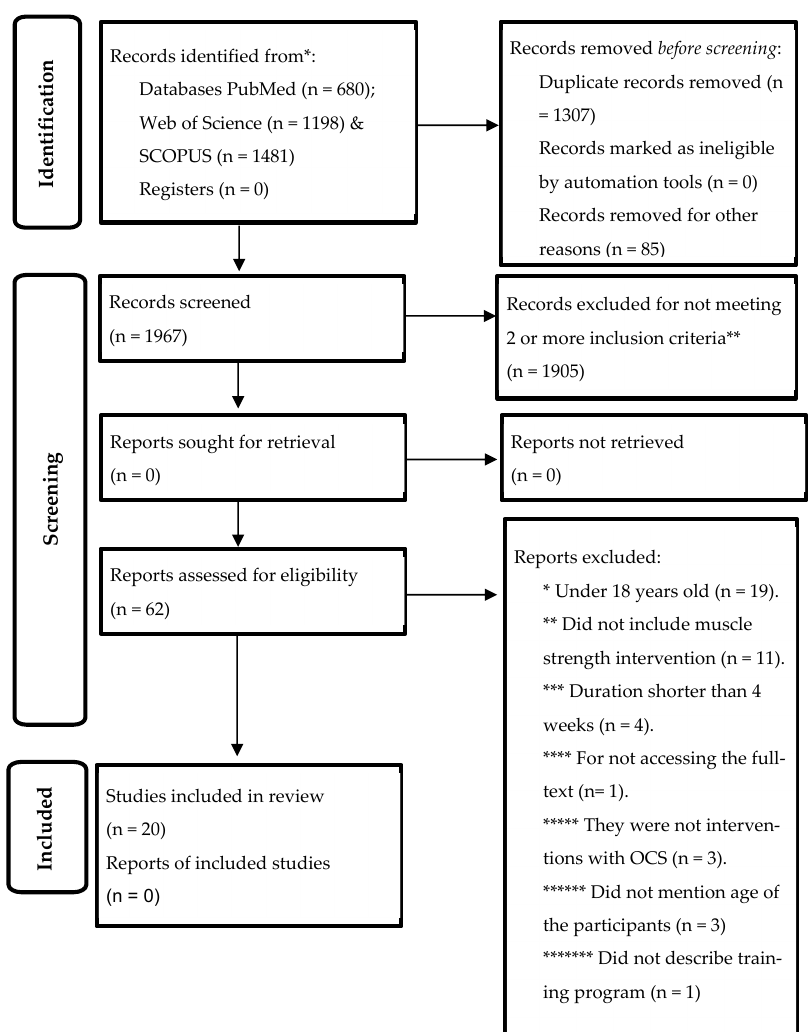
Figure 1. Flowchart of the review process. Based on the PRISMA guidelines [24].